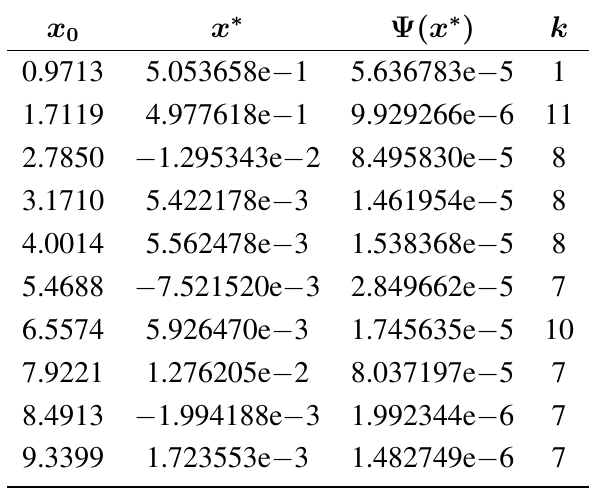
Table 1. Number of iterations and the final value of Ψ( x ∗ ) .